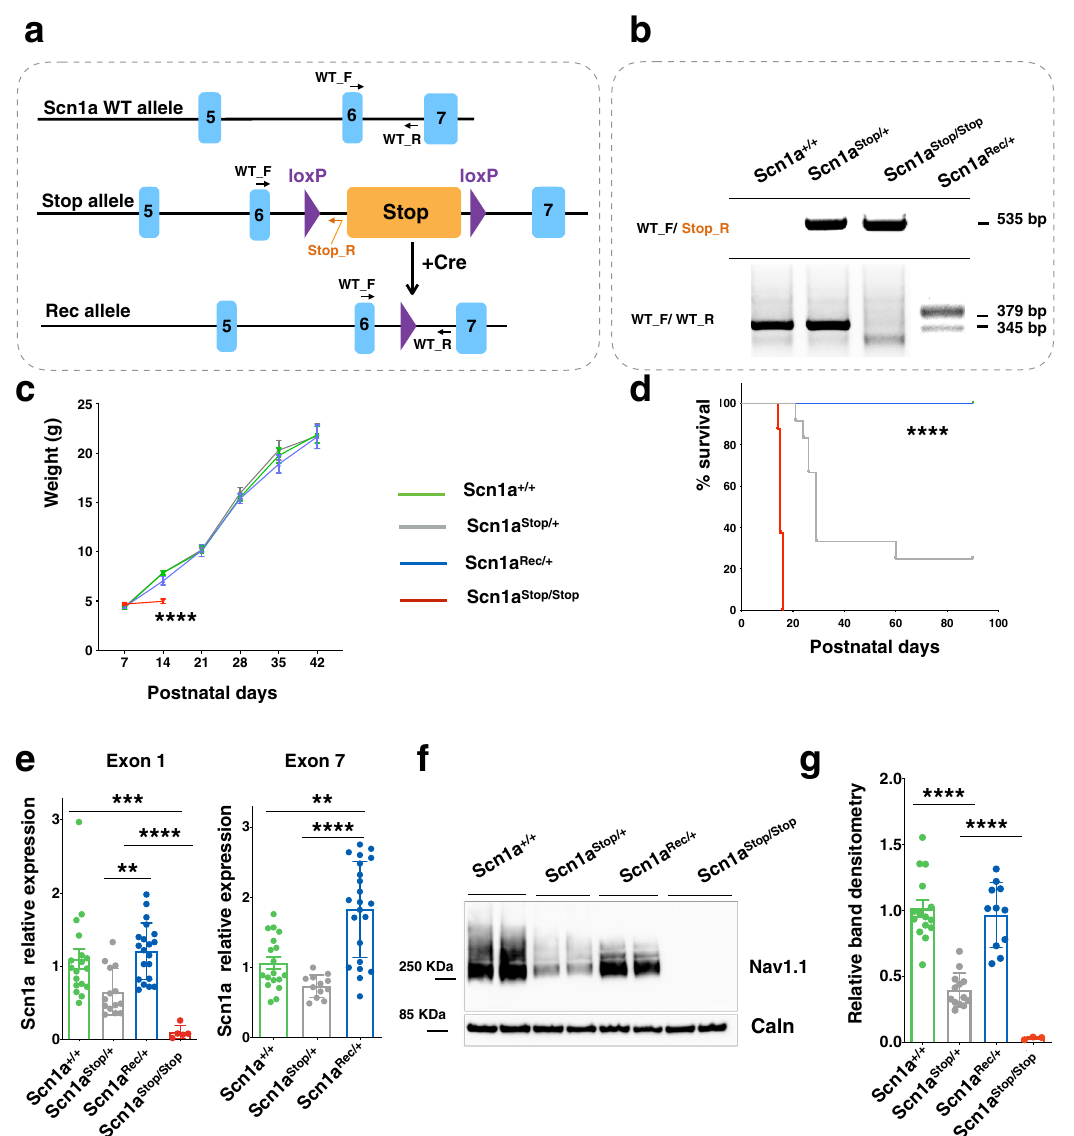
Fig. 1 Characterization of a Scn1a knock-in mice carrying a fl oxed STOP cassette between exon 6 and exon 7. a Schematic representation of the wild- type Scn1a allele, the knock-in allele containing the STOP cassette and the recombined allele after Cre-mediated removal of the STOP cassette. Grey boxes represent Scn1a exons and violet triangles LoxP sites. Primers for genotyping PCR are shown. b Genomic PCR products for genotyping Scn1a + / + , Scn1a Stop/ + , Scn1a Stop/Stop , and Scn1a Rec/ + c Body weight curves (from P7 to P42) of Scn1a + / + , Scn1a Stop/ + , and Scn1a Rec/ + and Scn1a Stop/Stop , mice ( n = 8 each group, two-way ANOVA with Tukey ’ s multiple comparison **** p < 0.0001 for genotype effect). d Survival of Scn1a Stop/ + (n = 12), Scn1a Rec/ + ( n = 11) and Scn1a Stop/Stop ( n = 8) mice monitored out to 90 days for survival, (**** p < 0.0001; Log-rank Mantel-Cox test). e qRT-PCR on RNA extracted from cerebral cortex to determine Scn1a transcript level in Scn1a + / + ( n = 18), Scn1a Stop/ + ( n = 14) and Scn1a Rec/ + n = 20) and Scn1a Stop/Stop ( n = 6) mice with